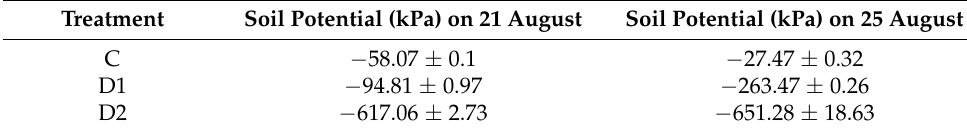
Table 1. Soil potential (kPa) (Mean ± standard deviation, n = 3) during measurements.